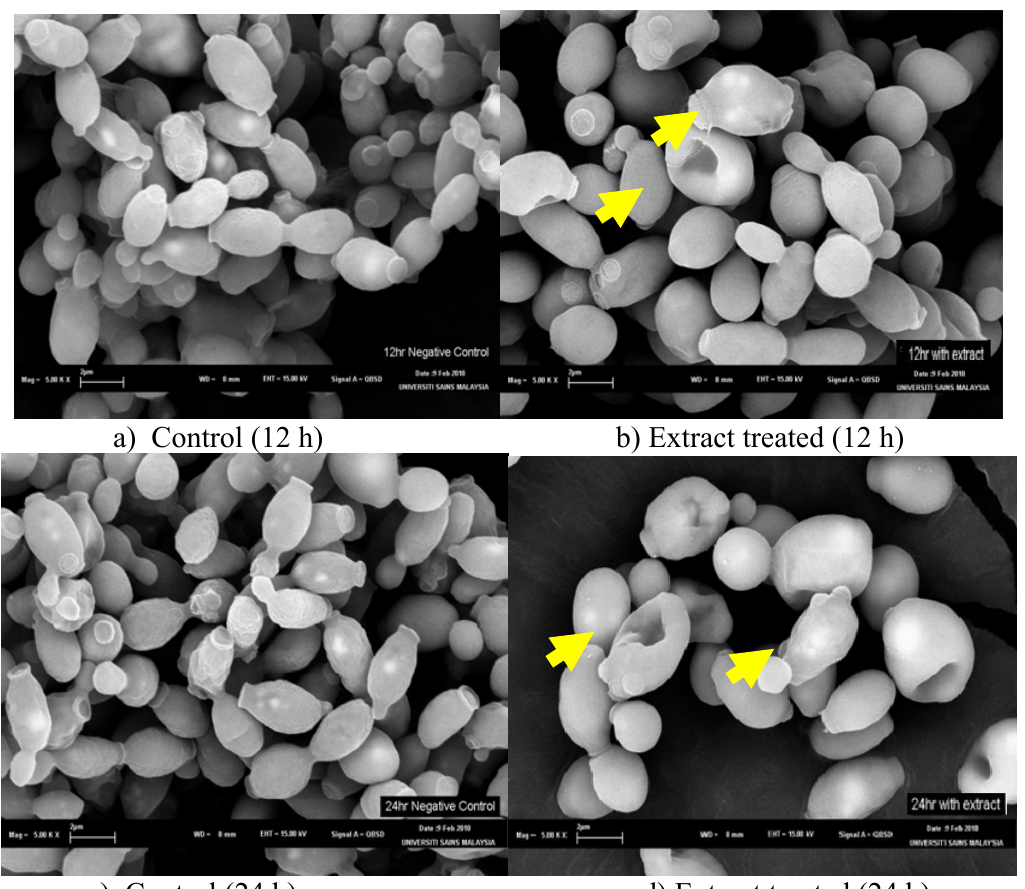
Figure 2. Scanning electron microscopic images (5.00 k x) of Candida albicans cells before and after treating with Euphorbia hirta leaves extract for 12, 24 and 36